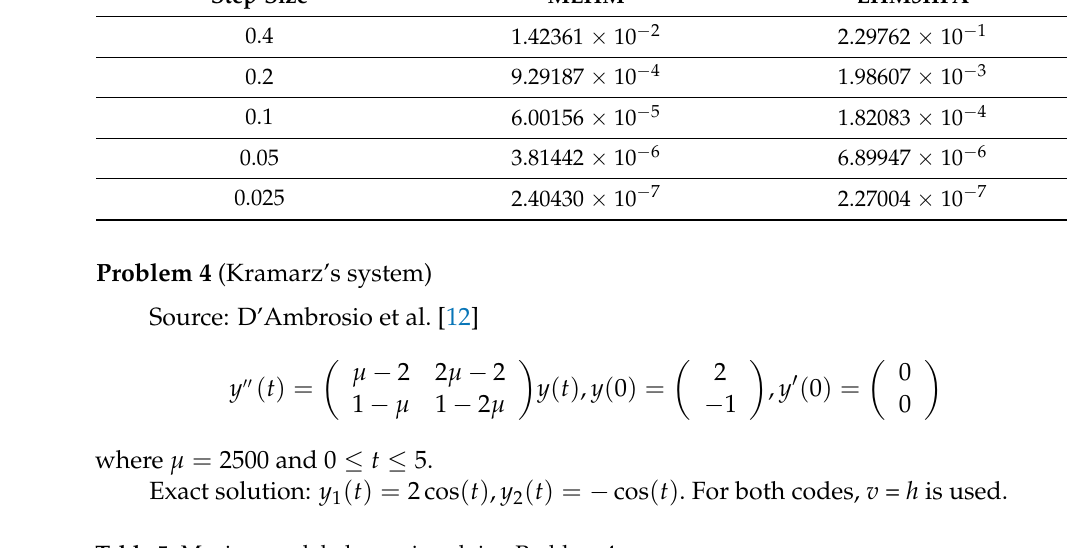
Table 5. Maximum global error in solving Problem